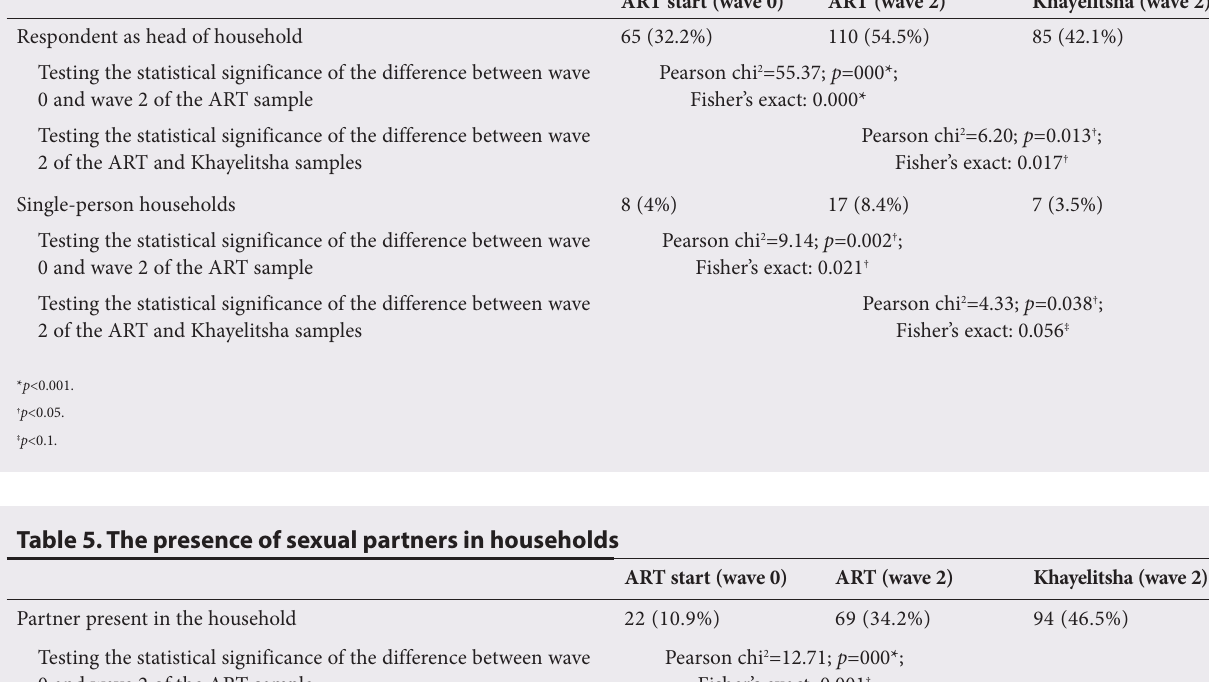
Table 4. Respondent-headed and single-person households